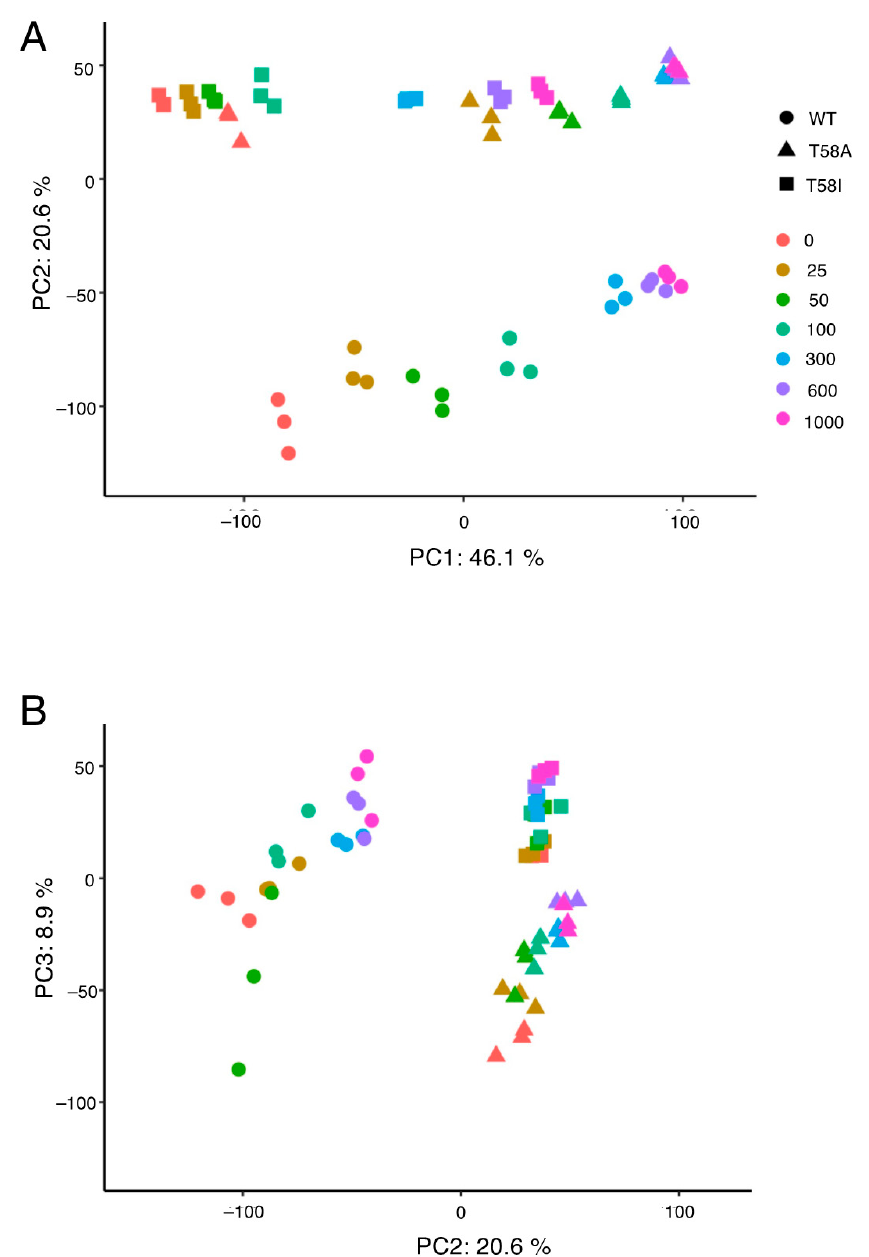
Figure 2. Principal component analysis of global gene expression data. The first three principal components describe 75.6% of the variation in the global gene expression data across the three MYC genotypes and seven expression levels. Levels of MYC WT (circles), MYC T58A (triangles) and MYC T58I (squares) were controlled by titrating in doxycycline at the indicated concentrations (ng/mL, colors). ( A ) Scatter plot of principal component (PC) 1 versus PC2. ( B ) Scatter plot of PC2 versus PC3. The proportion (%) of the variation accounted for by each PC is shown.